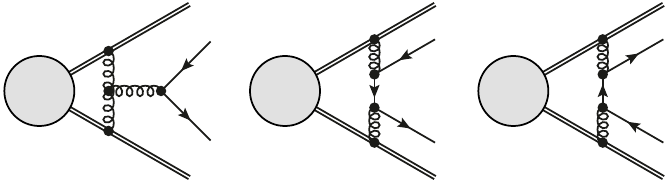
Figure 13 . Remaining diagrams with two Wilson